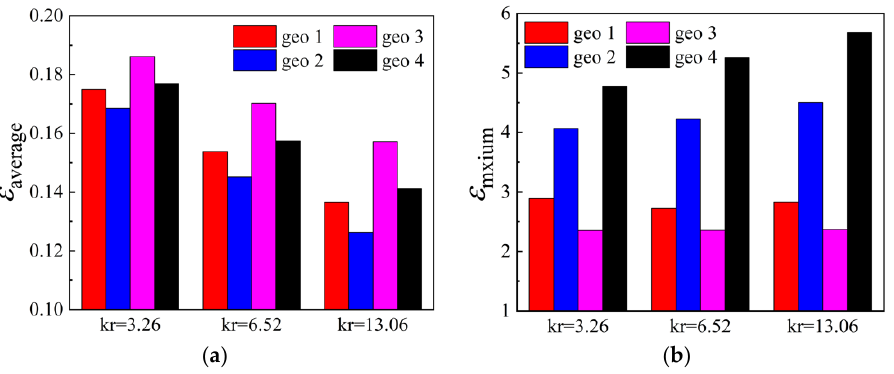
Figure 17. Histogram of the thermal gradient with different cases: ( a ) 𝜀 average of CCR with different Kr, and ( b ) 𝜀 maximum of CCR with different Kr.